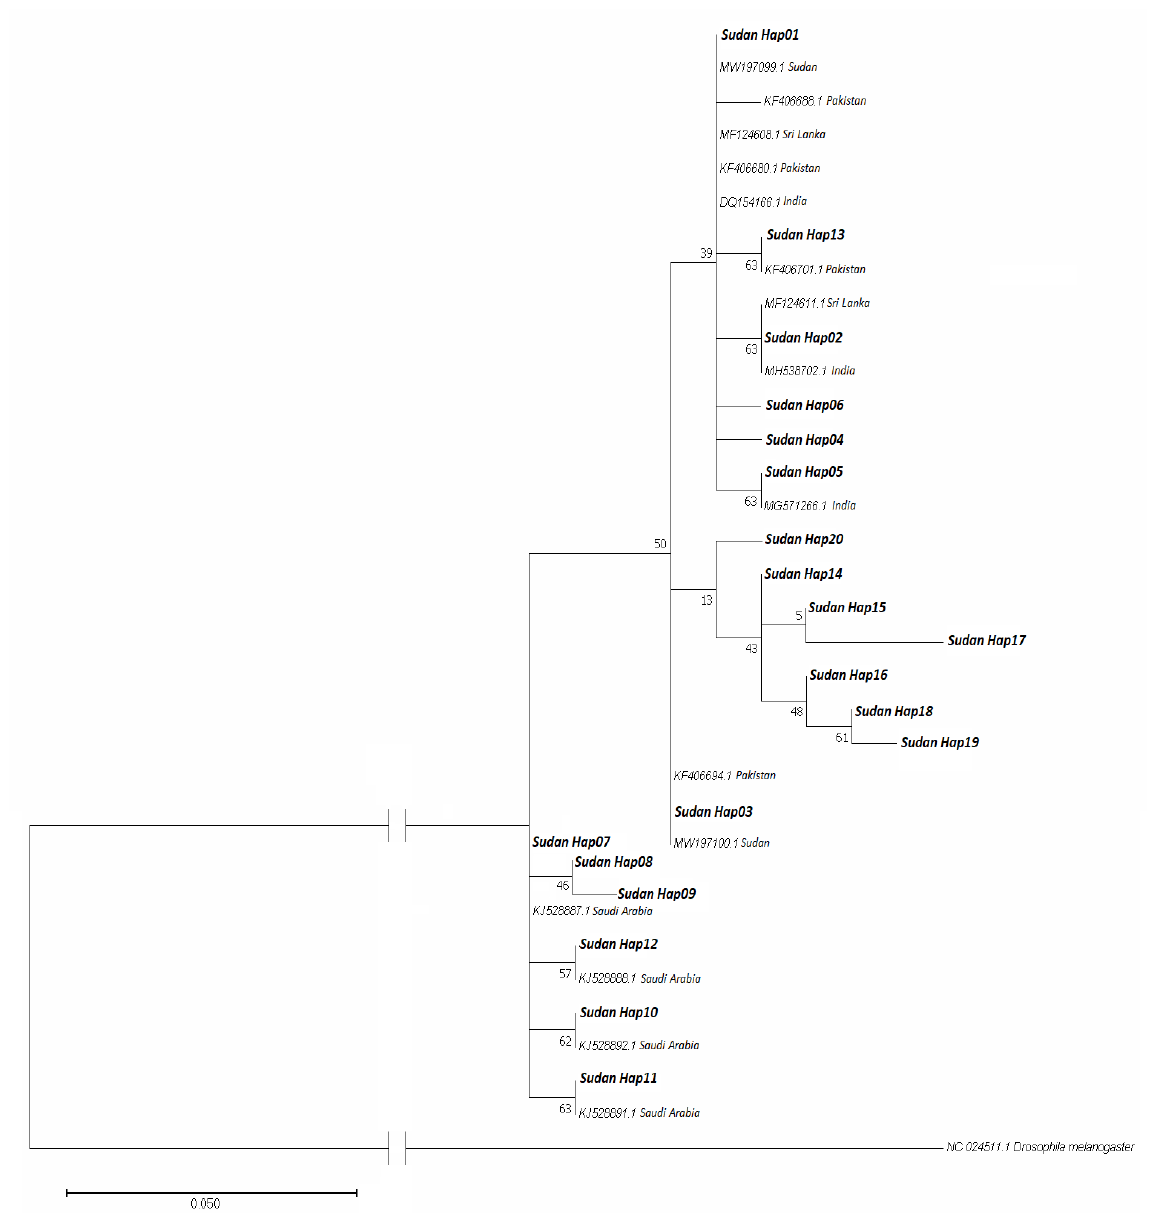
Figure 4. Phylogenetic tree showing the relationship between the Sudanese An. stephensi haplotypes with 15 reference sequences. Sudanese haplotypes (Sudan Hap01 – Sudan Hap20) are in bold. The reference sequences along with their accession numbers and origin of isolate were included for each. Drosophila melanogaster was used as an outgroup taxon.